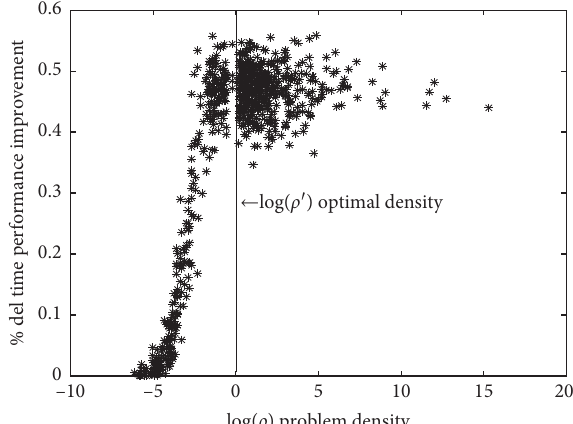
Figure 6: As problem delivery density nears optimal density for the system, performance